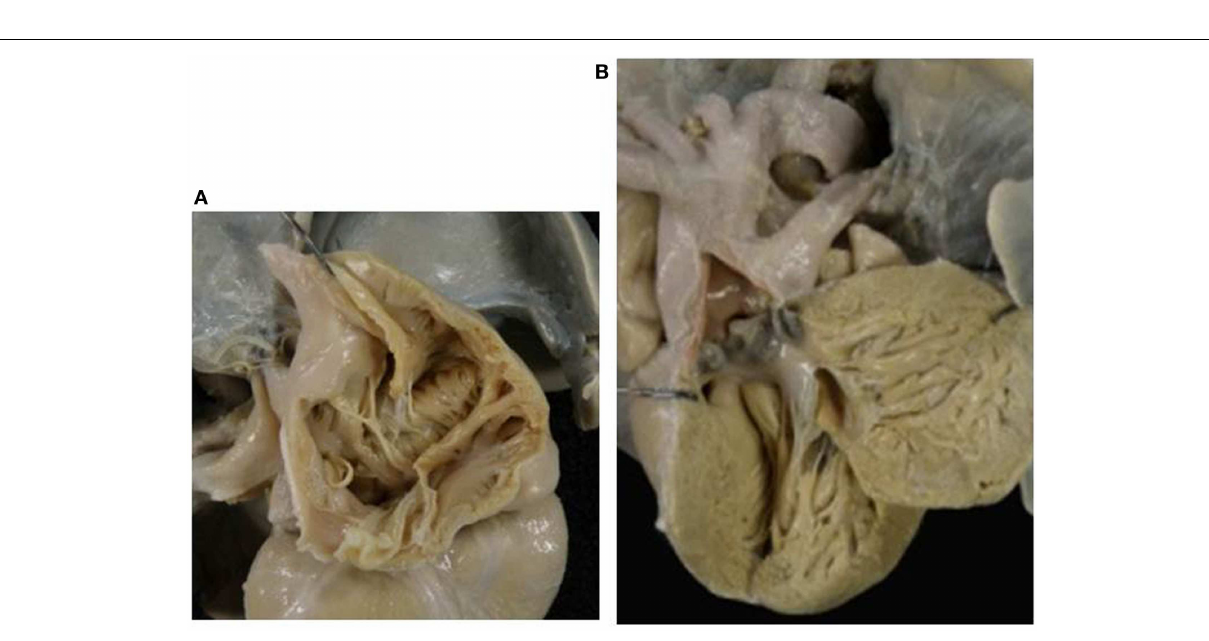
FIGURE 10 |Absent leftAV valve (tricuspid atresia) with truncus arteriosus . (A) There is no orifice in the floor of the right atrium. (B) A common arterial trunk arises from the heart, prevalently from the left ventricle, and gives origin to both systemic and pulmonary circulations. Note the dysplastic, tricuspid truncal